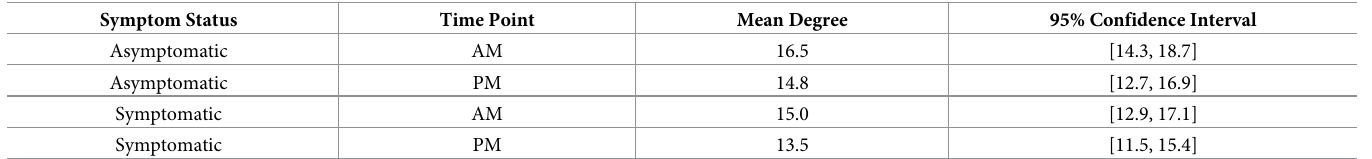
Table 4. Inferred mean degree by symptom status and time